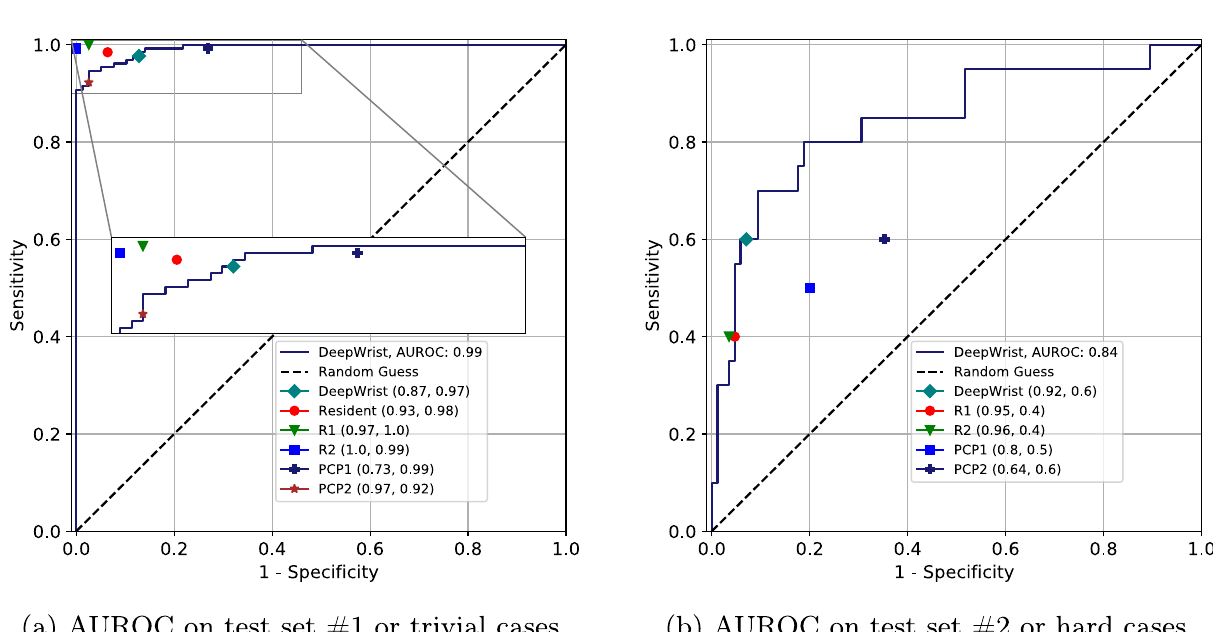
Figure 2. ( a ) AUROC performance of DeepWrist on test set #1 compared to a radiology resident, two radiologists (R1 & R2), and two primary care physicians (PCP1, PCP2), ( b ) AUROC performance of DeepWrist on test set